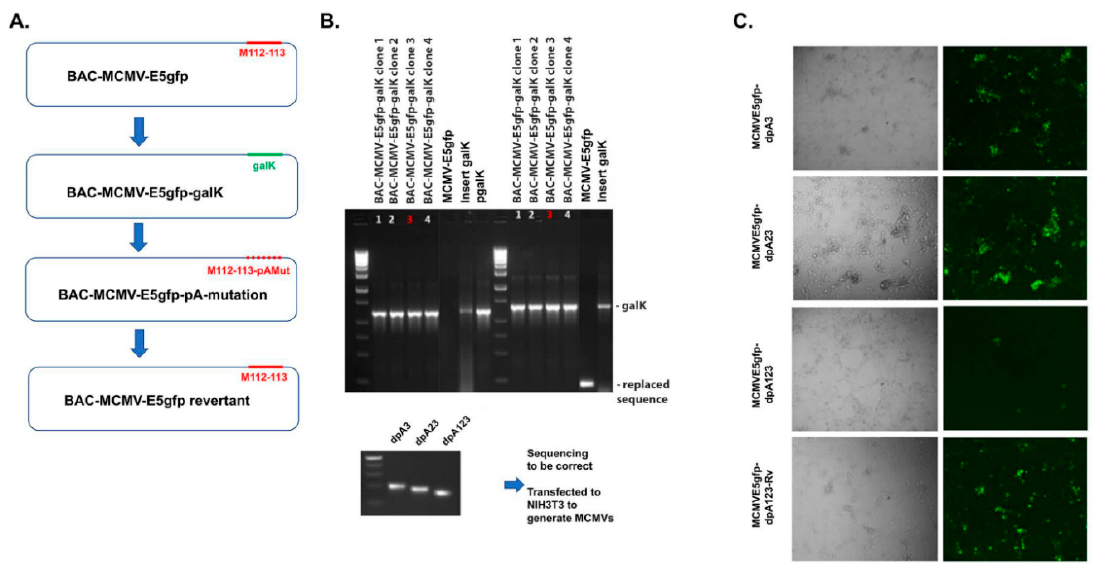
Figure 4. BAC mutagenesis to make mutant murine cytomegalovirus (MCMV). ( A ) A scheme of mutagenesis by BAC of MCMV. ( B ) PCR and DNA sequencing to identify the resultant BAC DNA. ( C ) BAC DNAs were transfected into NIH3T3 to generate MCMV mutants. The green dot-like cells show the formed plaques because the IE3 was tagged with GFP at its C-terminus of exon 5. The image was taken under a 10× magnificstion len of the microscope.